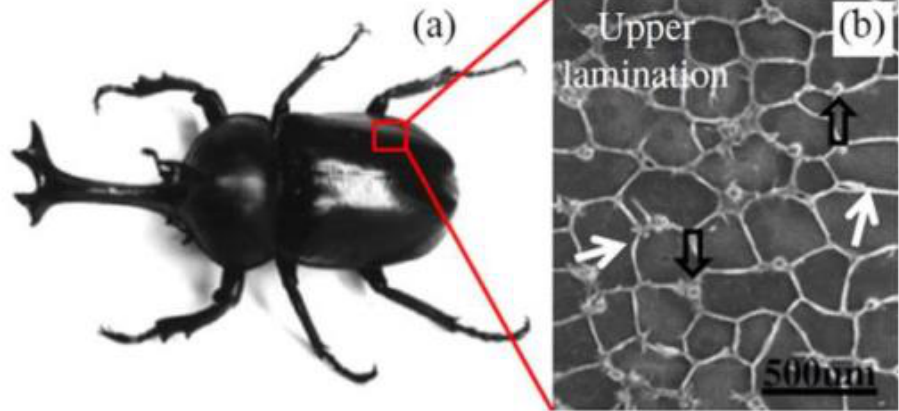
Figure 1. The beetle and its microstructure: ( a ) the beetle Allomyrina dichotoma ; ( b ) micromorphology of HS with columns [12].